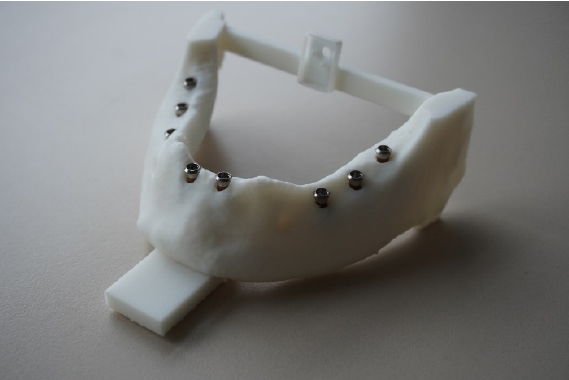
Figure 1. Imaged is the master typodont with the eight implants, which the young professionals had to implant in the same way with the dynamic computer-assisted surgical system. The prefabricated marker has to be placed in the acrylic structure in the middle of both rami of the mandible. Denacam is a dynamic computer-assisted surgical system and uses the principles of stereo triangulation of optical cameras. As a real-time navigation system, Denacam uses a small, prefabricated intraoral marker to coordinate the planned implant position and the real-time position of the drill during surgery. The prefabricated marker was placed between both rami of the mandible in acrylic. The surgeon detects deviations in the